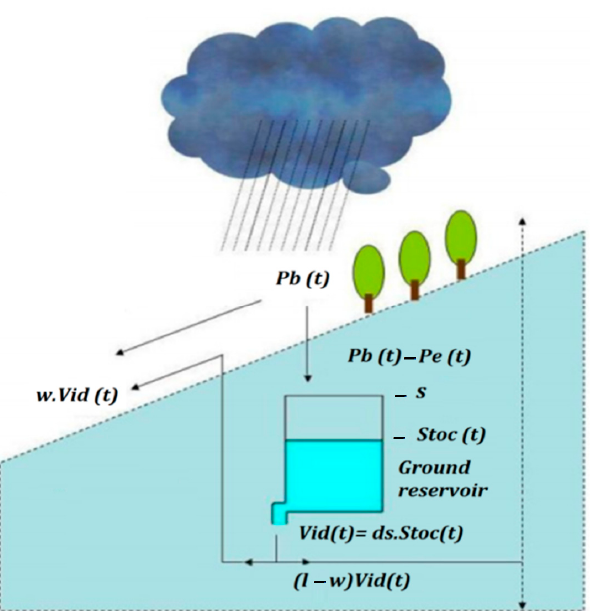
Figure 5. Principle of the SCS production function (www.athys-soft.org, accessed on 15 March 2022).